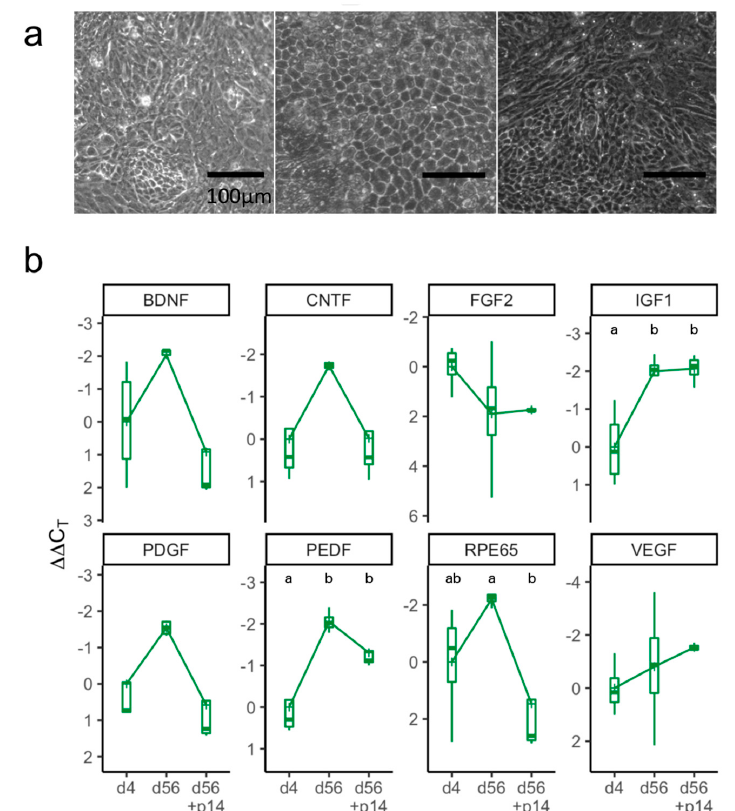
Figure 5. Markers of maturation are lost after passaging E-RPE cells. ( a ) Morphology of E-RPE cells at confluence, four days after seeding (left), at 56 days of maturation (center) and at a further 14 days after passaging (right). Scale bar represents 100 µm. ( b ) RT-qPCR analysis at three time points (4 days, 56 days and 56 + 14 days after passaging). Results were normalized to PPIA and represent mean ΔΔ Ct values ( n = 3 or 4) ± standard deviation plotted on a negative y -axis (higher expression at the top). Kruskal-Wallis one-way ANOVA test was used to compare ΔΔ Ct values of the various maturation points within each gene followed by a Tukey’s honest significance test; different letters, p < 0.05.